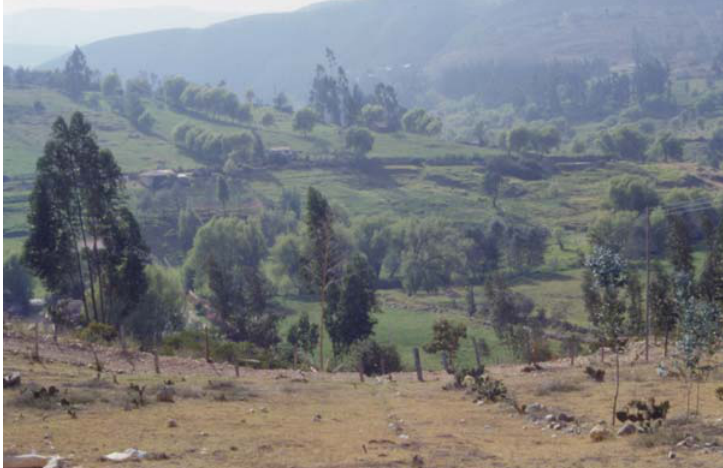
Figure 20. The moist valley at